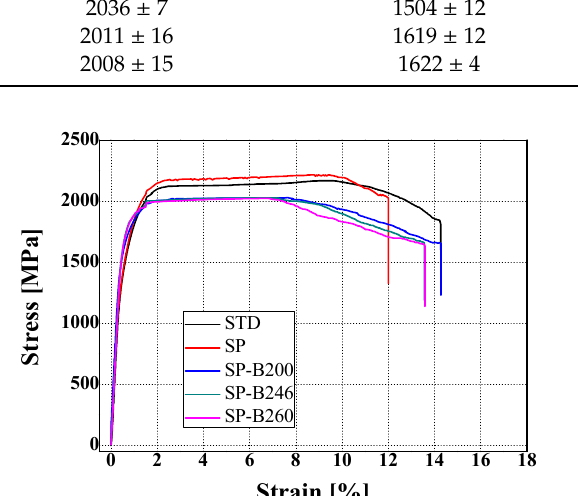
Table 4. Mechanical properties obtained from the tensile test of 4340M steel.